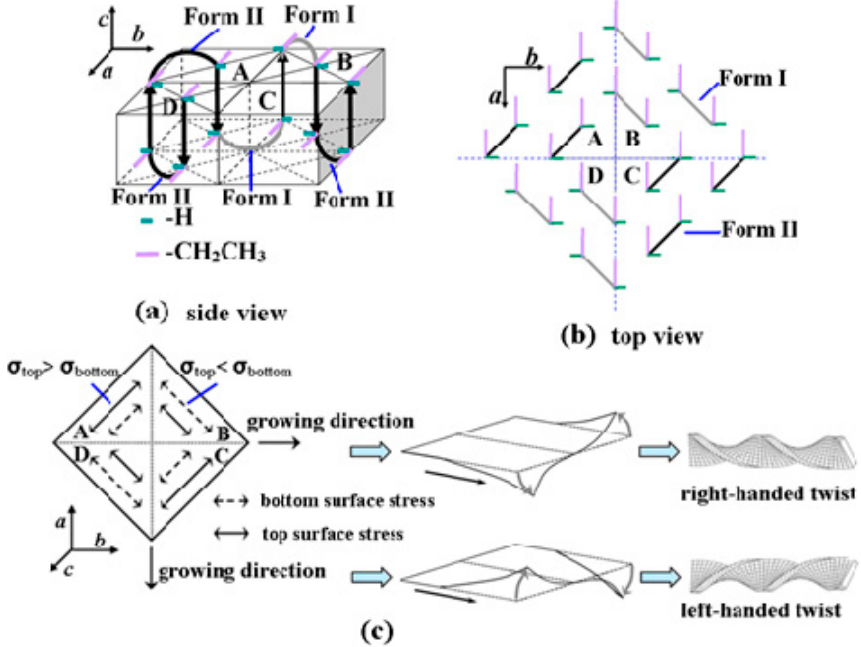
Figure 16. Mechanical model interpreting the origin of the unbalanced anisotropic surface stresses and the resultant opposite twist handedness along the two orthogonal axes of PHV lamella. ( a ) The side view of the configuration of the chain stems and the folds on the opposite lamellar surfaces of a single lamella, wherein the configurations are simplified according to the symmetry rule that a , b, and c axes are the three 2 1 screw axes. A, B, C, and D indicate the four sectors of a lamella. The bold black arrows indicate the helical chain stems with up or down direction. ( b ) The top view of the folds on the lamellar surface. The folds of form I and those of form II are of different encumbrances. ( c ) The scheme of lamellar twist sense induced by the unbalanced surface stresses along the two orthogonal growth axes. The twisting lamella scheme is adopted from Ref. [66] and the cooperative behavior of two half lamellae is redrawn from Ref. [6]. Reprinted with permission from Ref. [17]. Copyright (2009) American Chemical Society.